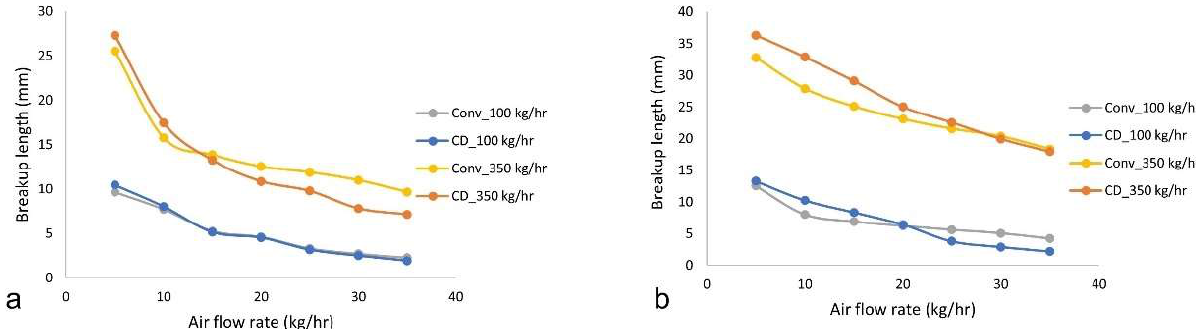
Figure 14. Breakup length measurement for both the converging and CD atomizer for two cases: ( a ) 70 µm sheet thickness and ( b ) 280 µm sheet thickness.